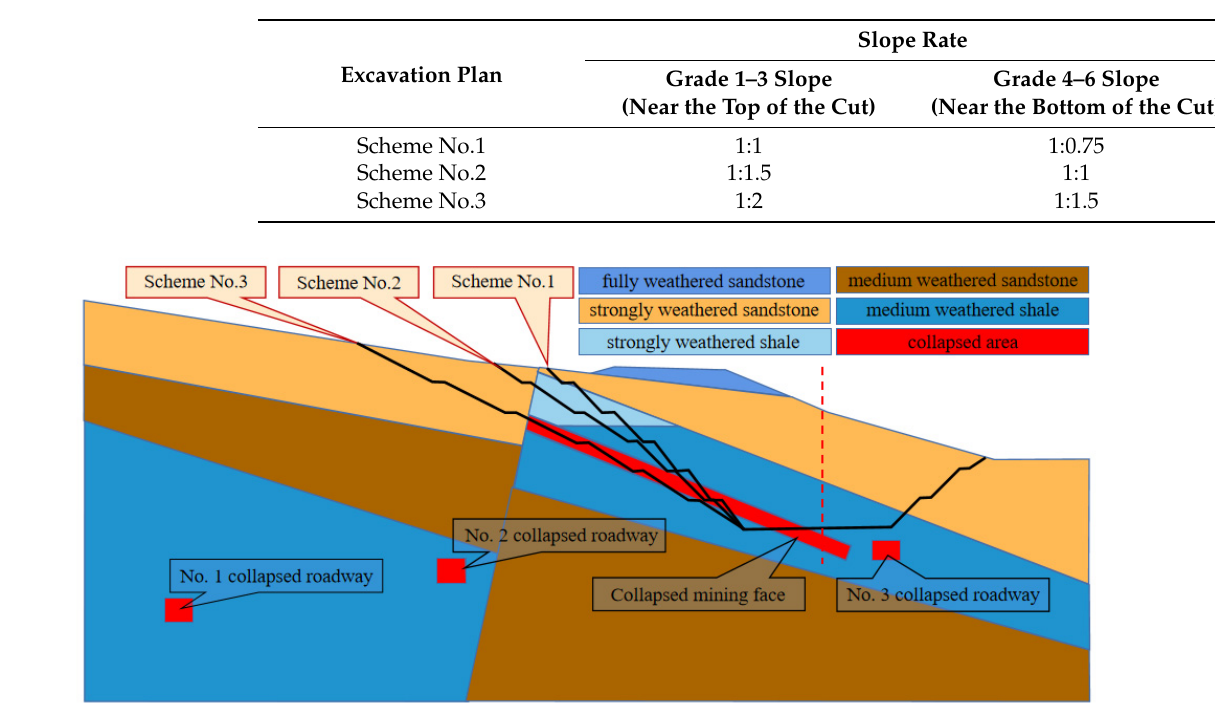
Figure 2. Excavation line and engineering geology cross section of each scheme. In the above picture, the horizontal distance from the No.1 collapsed roadway to the excavation slope toe is − 120 m, and the vertical distance is − 12 m. The No.2 collapsed roadway has a horizontal distance of − 65 m and a vertical distance of − 5 m from the excavation slope toe, and is located below the top of the slope. The No.3 collapsed roadway is 20 m horizontally from the excavation slope toe and has a vertical distance of − 2 m.